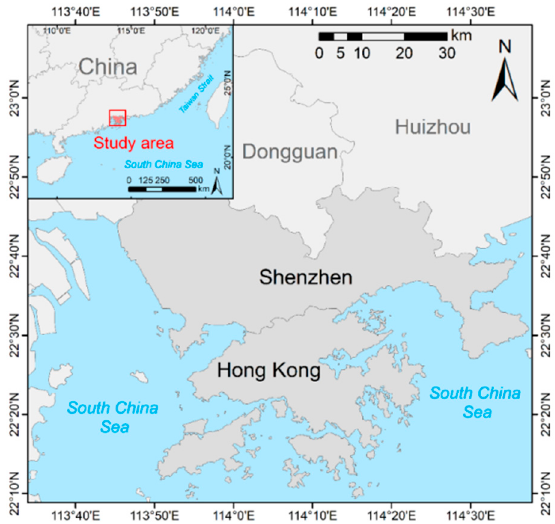
Figure 1. Map of the study area (i.e., Shenzhen and Hong Kong). In the inset, the red box indicates the location of the study area.